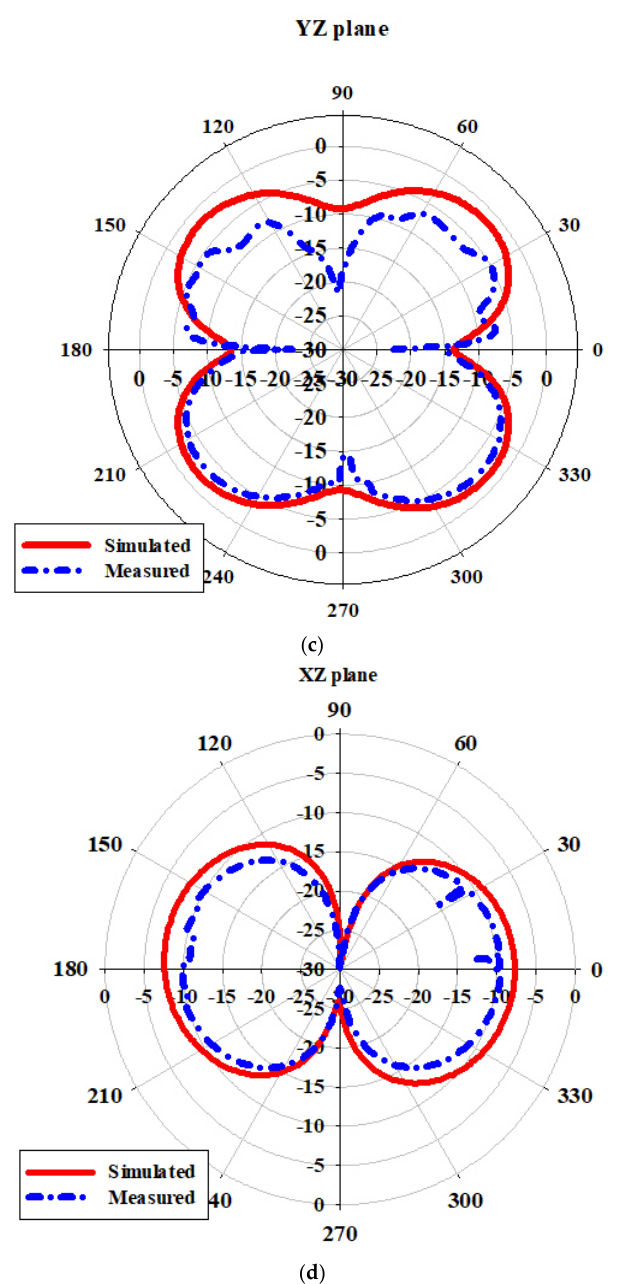
Figure 11. Radiation pattern, both simulated and measured, of the designed antenna operating at 2.4 GHz ( a ) radiation pattern measurement setup ( b ) xy, ( c ) yz, and ( d ) xz